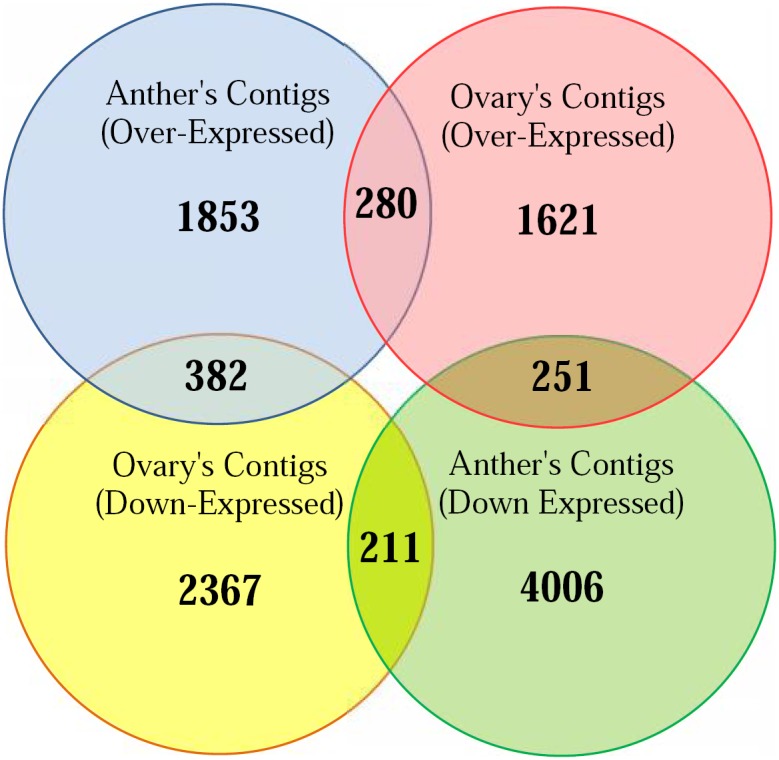
Homology of almond transcriptome to other plant species.The percent of BLASTX top-hit with different plant species. Maximum homology of almond transcripts were observed with peach (Prunus persica).